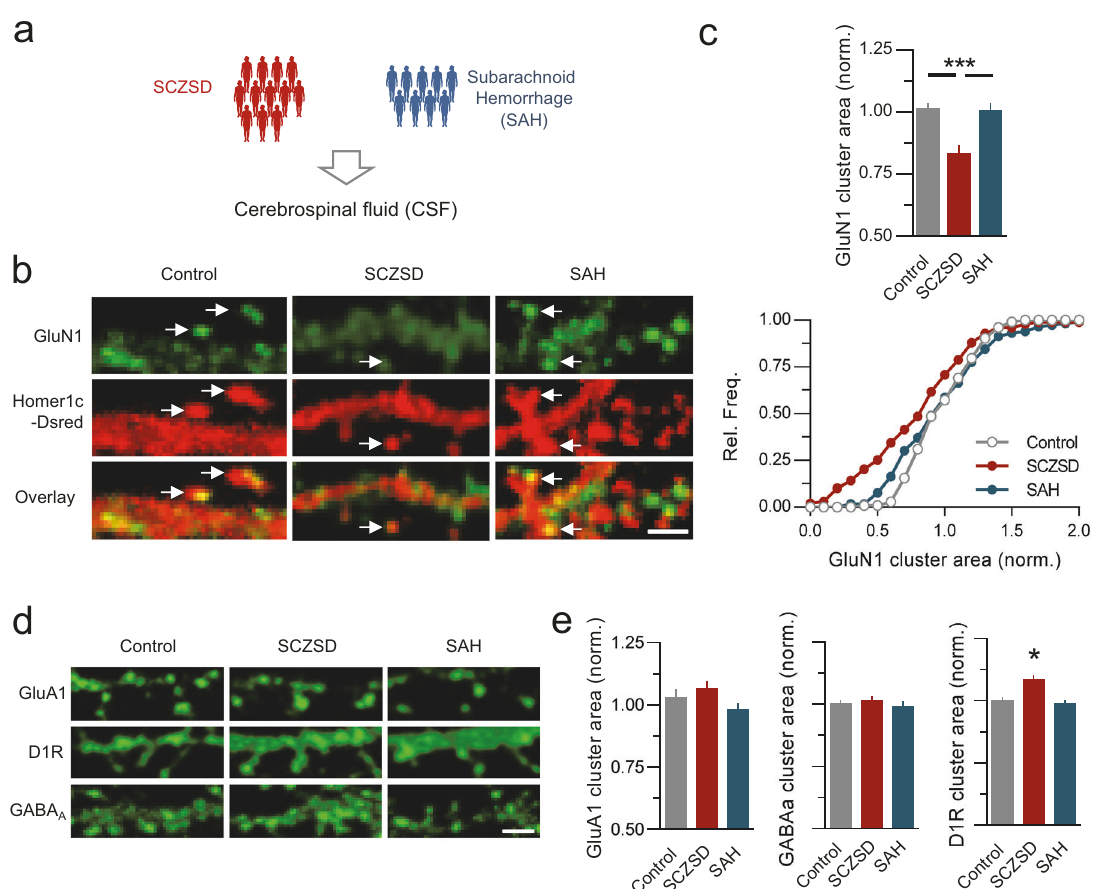
Fig. 2 CSF from patients with SCZSD speci fi cally alters NMDAR surface clusters. a Schematic description of the experimental work fl ow, with the collection of CSF from patients with subarachnoid hemorrhage (SAH, n = 9 patients) and schizophrenic spectrum disorders (SCZSD, n = 12). b Surface immunostaining for GluN1-SEP NMDAR (green) onto neurons transfected with Homer1c-DsRed (red) and exposed to SCZSD or SAH CSF. Arrows indicate postsynaptic areas. Scale bar = 1 µm. c The area of GluN1-NMDAR surface clusters were signi fi cantly reduced by SCZSD CSF (Control, n = 103 clusters; SCZSD, n = 99; SAH, n = 116; N = 6 – 8 neurons per condition; *** p < 0.001, ANOVA 1 followed by Newman – Keuls multiple comparisons test). Below , Cumulative distributions of GluN1-NMDAR cluster area between conditions. d Surface immunostaining of GluA1-AMPA, Dopamine D1 (D1R), or GABAa receptor onto neurons exposed to SCZSD or SAH CSF. Scale bar = 1 µm. e Comparison of the area of surface clusters for GluA1-AMPA receptor (Control, n = 129 clusters; SCZSD, n = 130; SAH, n = 139; N = 6 – 8 neurons per condition), GABAa receptor (Control, n = 140; SCZSD, n = 182; SAH, n = 146; N = 6 – 8 neurons per condition), D1R (Control, n = 87; SCZSD, n = 100; SAH, n = 90; N = 6 – 8 neurons per condition; * p < 0.05, ANOVA 1 followed by Newman – Keuls multiple comparisons